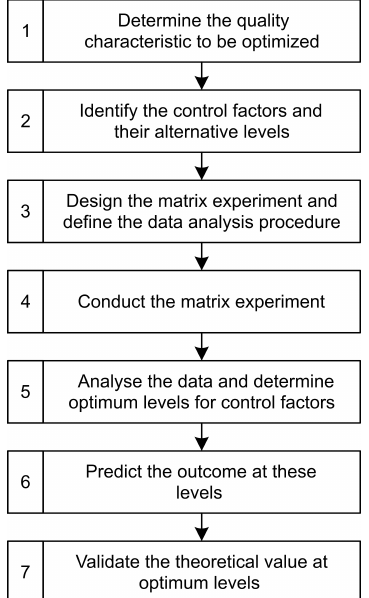
Figure 5. Flowchart of the tasks carried out in this paper according to Unal and Dean [13].